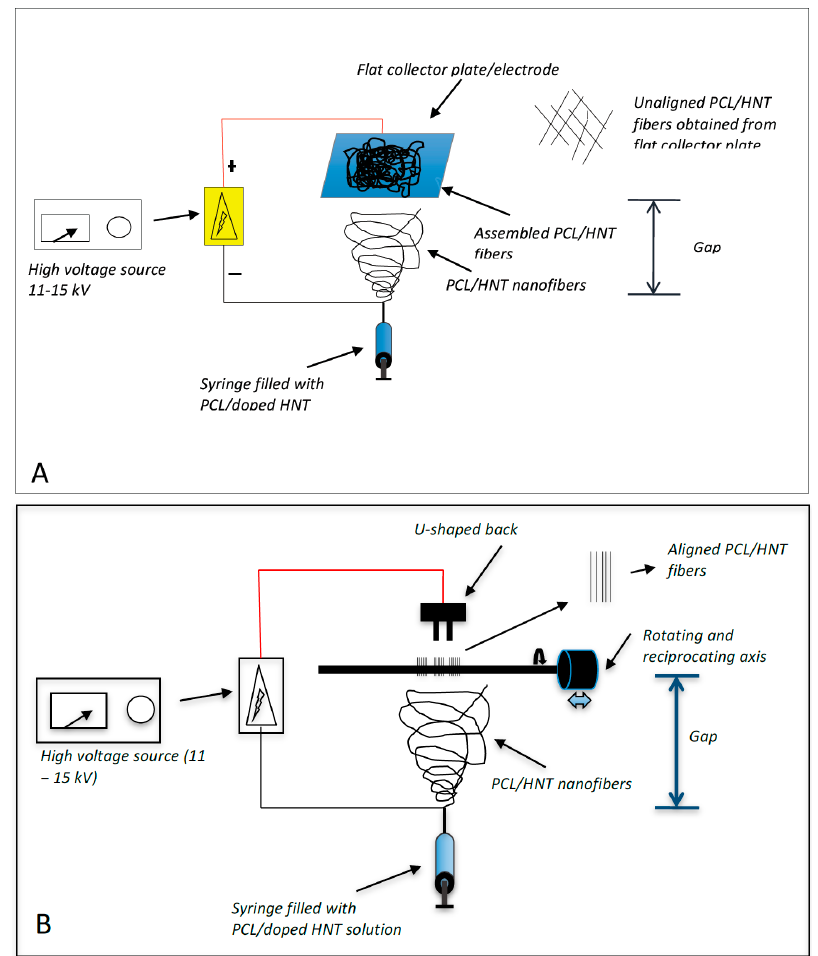
Figure 1. Electrospinning assembly set-up. ( A ) shows the assembly system that produced woven PCL fibers with no fiber orientation; ( B ) shows the assembly system that produced oriented (uniaxial) PCL fibers.